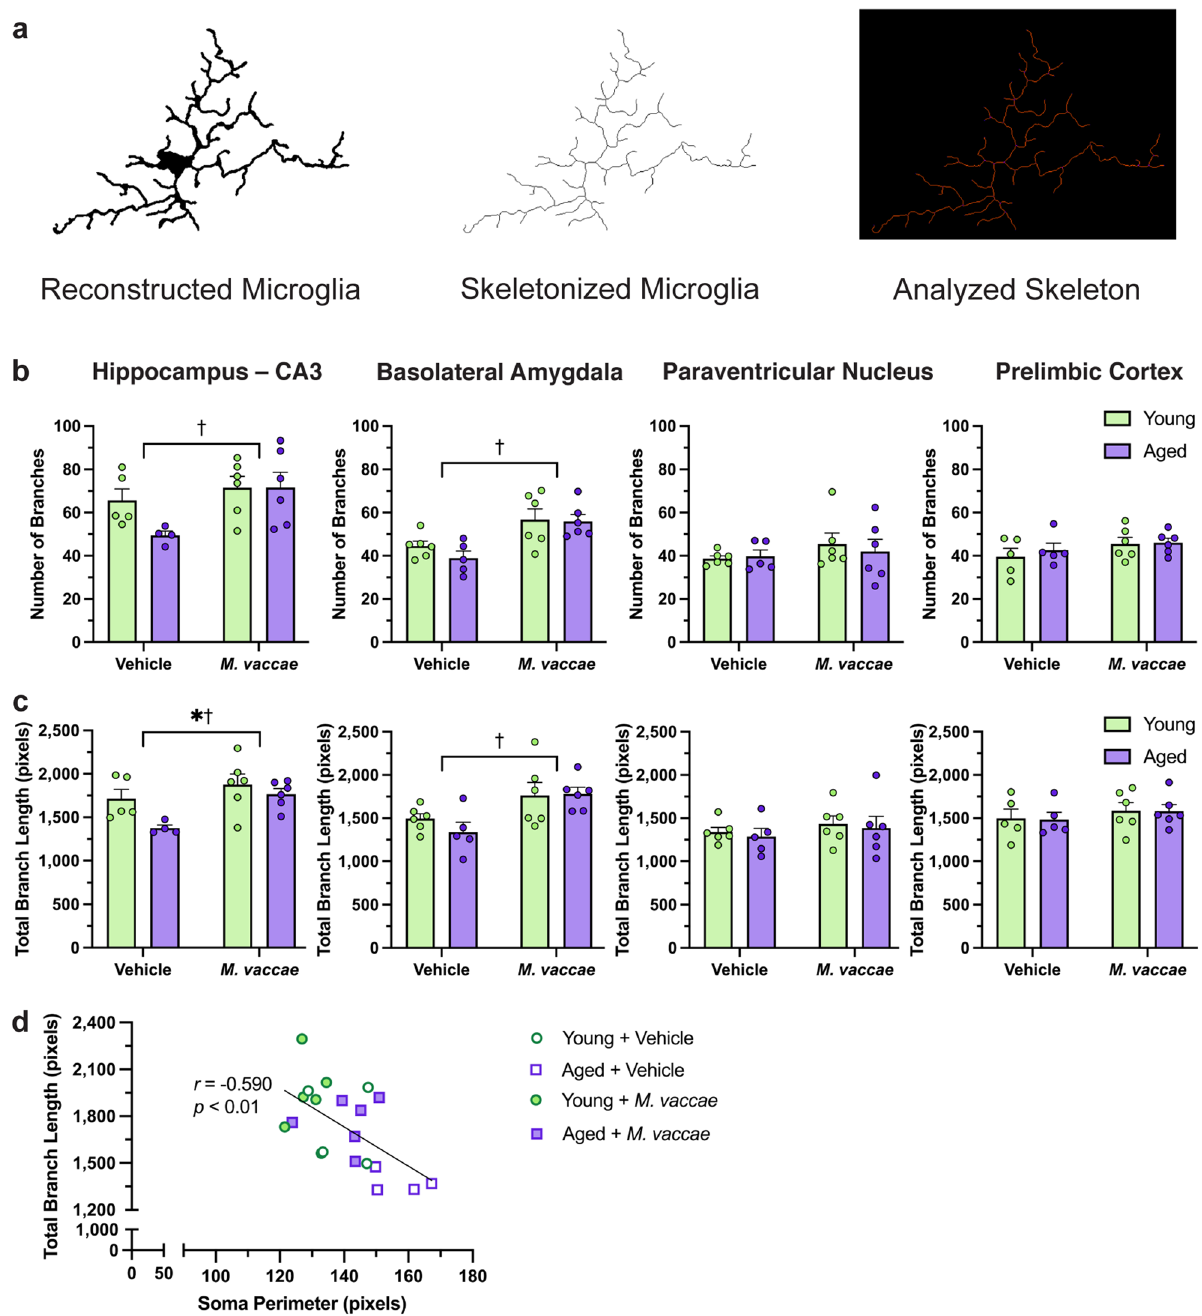
Figure 5. Skeletonization analysis suggest that microglia from the basolateral amygdala and hippocampus are responsive to M. vaccae immunization. ( a ) Methodology for performing the skeletonization analysis. Reconstructed microglia from the Sholl analysis were skeletonized and processed using a plug-in on FIJI. ( b ) The number of branches were calculated for each skeleton. A branch is considered a continuous segment that connects endpoints, endpoints and junctions, or junctions and junctions. ( c ) The total branch length was computed for each skeleton. This is the sum of each individual pixel in a skeletonized image. ( d ) Linear regression analysis between total branch length and soma perimeter from the hippocampus reveals a negative correlation. The data are graphed as mean ± SEM; n = 4–6 rats/group; * p < 0.05, main effect of age; † p < 0.05, main effect of M. vaccae